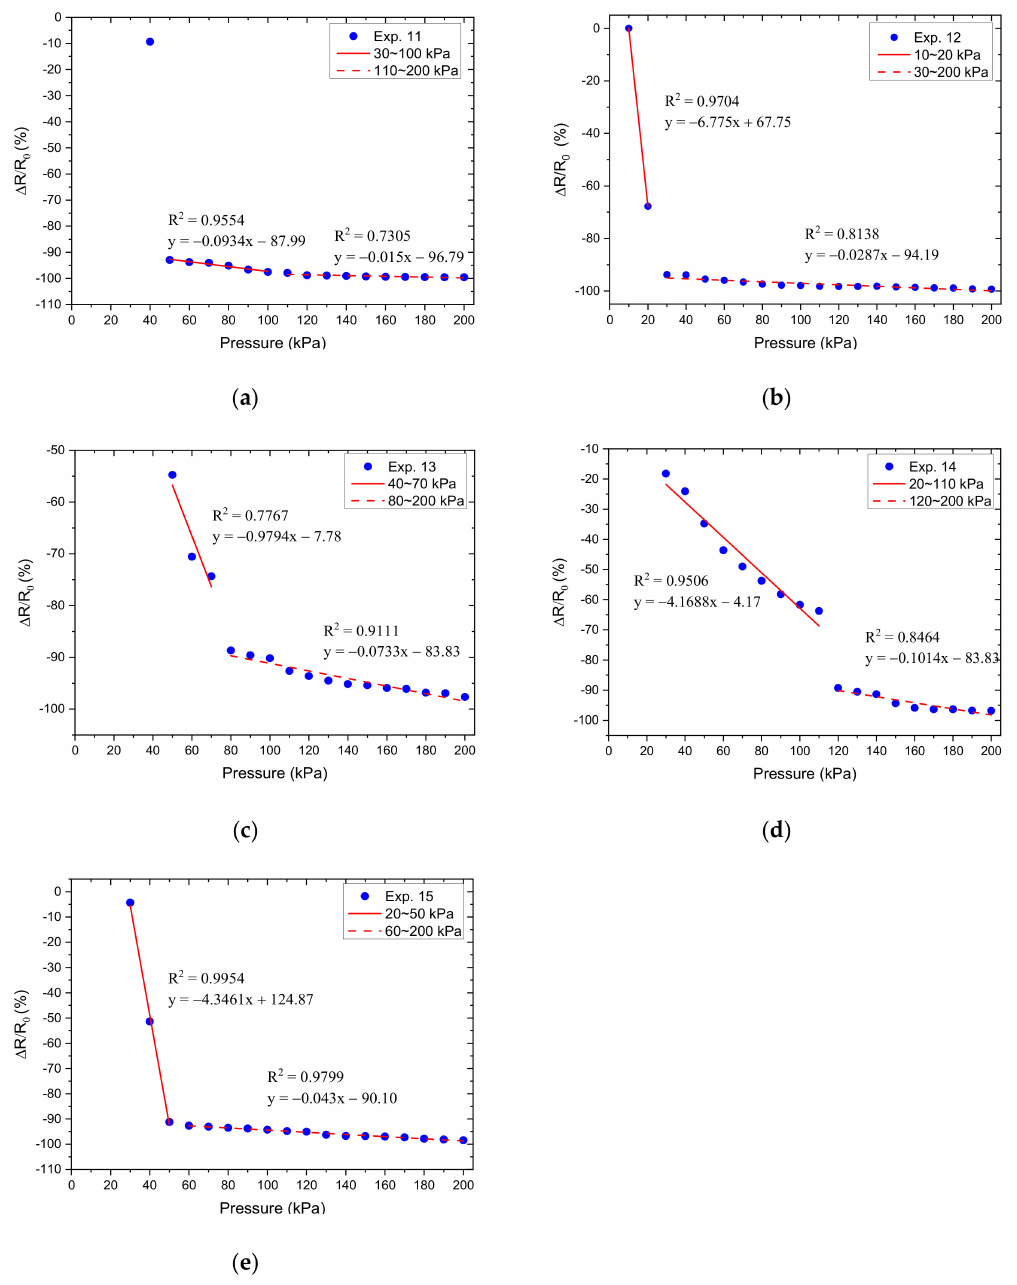
Figure 20. The relative resistance changes as a function of applied pressure for different grid microstructures in which ( a – e ) corresponds to experiments